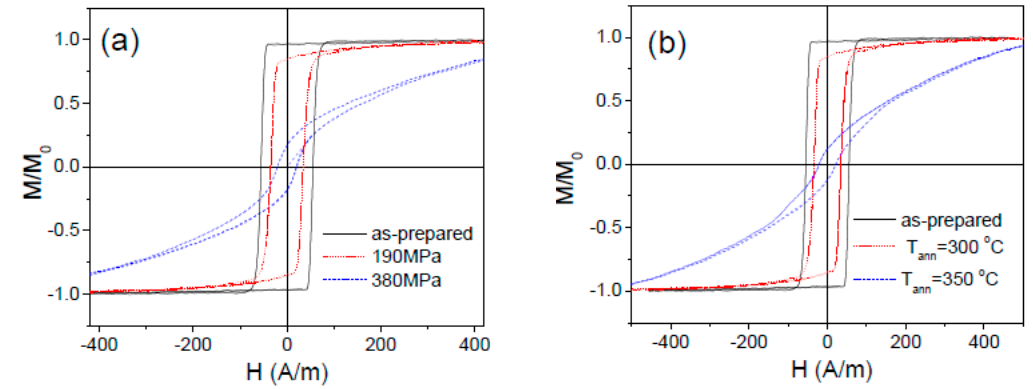
Figure 14. Effect of tensile stress applied during the annealing at 300 °C ( t ann = 60 min) ( a ) and annealing temperature at fixed σ a = 190 MPa; ( b ) on hysteresis loops of Fe 75 B 9 Si 12 C 4 microwire.